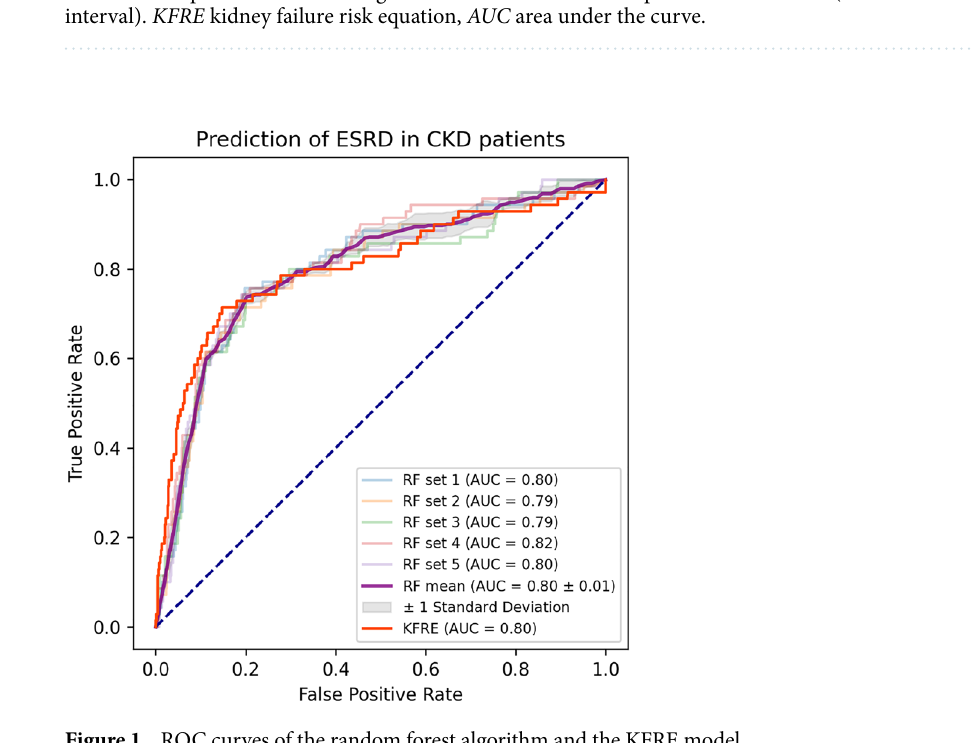
Figure 1. ROC curves of the random forest algorithm and the KFRE